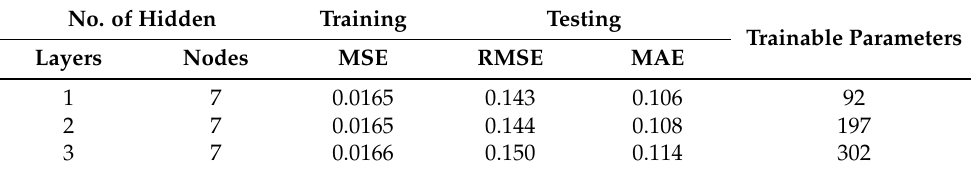
Table 16. Impact of hidden layers on the performance of the model “RDM-2”. No. of Hidden